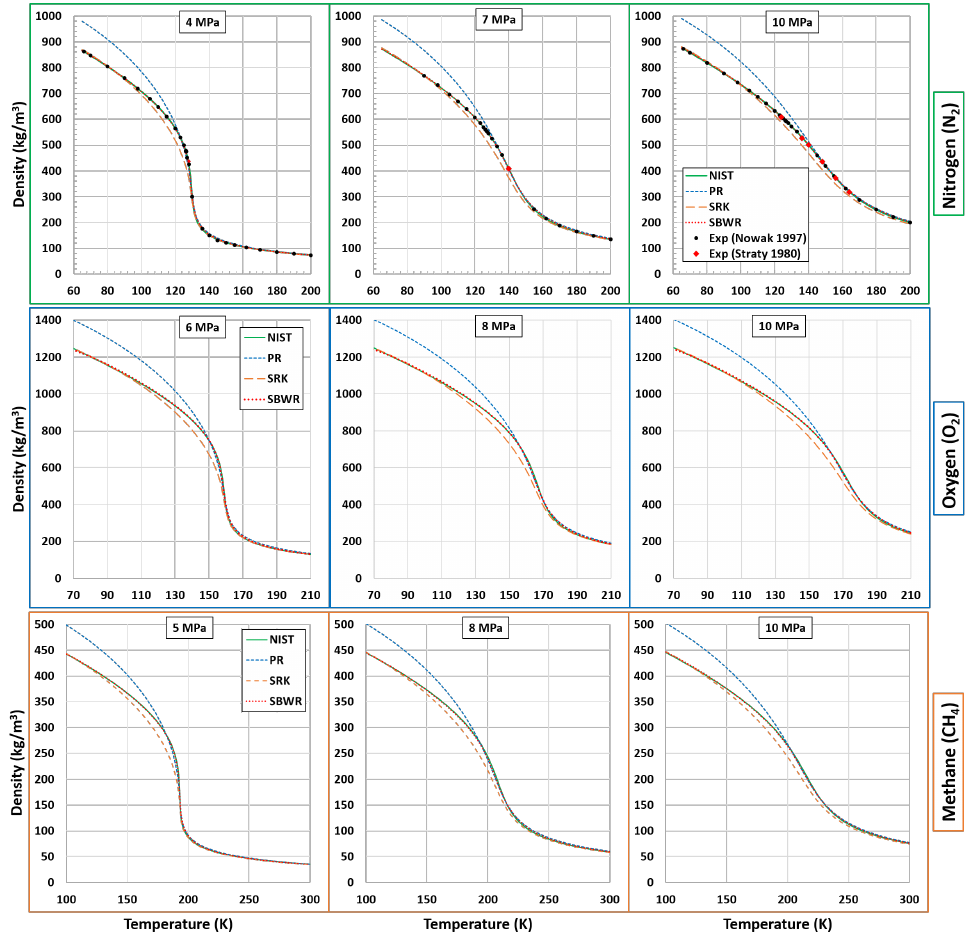
Figure 2. Plots of estimated density using PR, SRK and SBWR EoS compared with NIST and experimental data by Nowak [65] and Straty [66] for cryogenic fluids (N 2 , O 2 and CH 4 ) at three supercritical